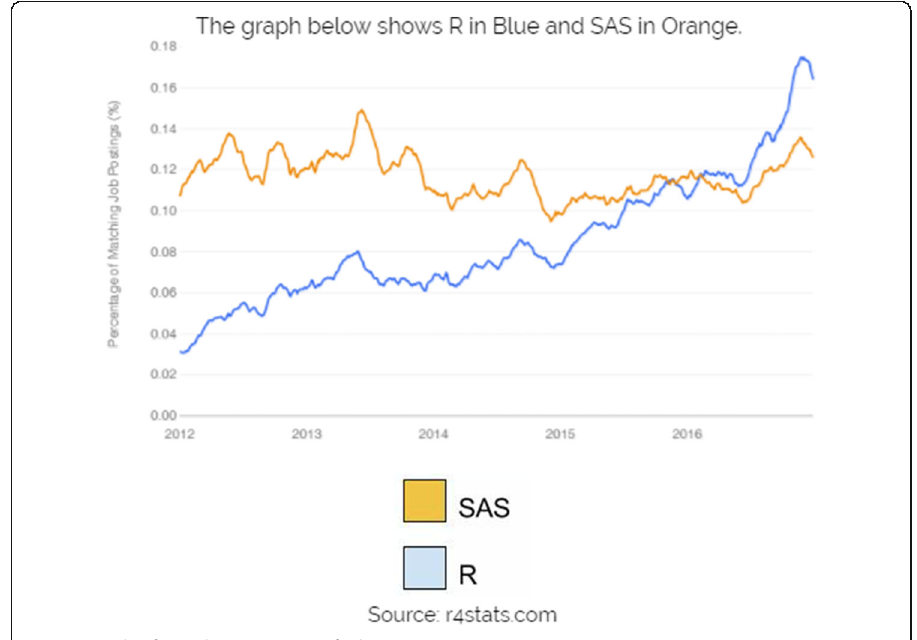
Fig. 4 Trends of R and SAS in terms of job